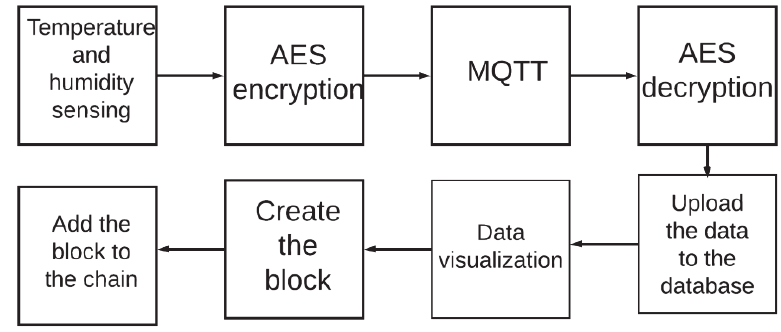
Figure 3. Proposed methodology.